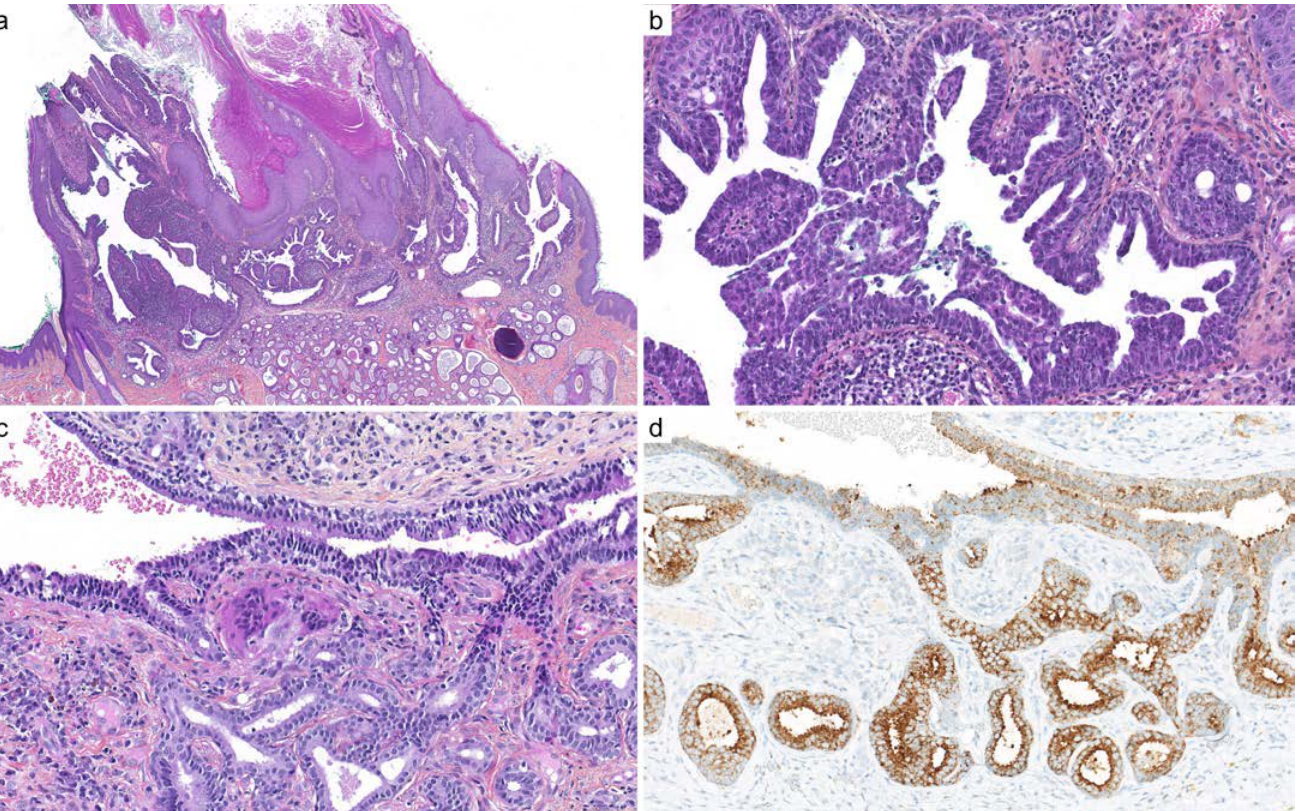
Figure 8. Syringocystadenoma papilliferum and tubular adenoma: ( a ) hybrid lesion with superficial syringocystadenoma papilliferum and dermal tubular adenoma arising on a nevus sebaceous, with verrucous change (×10) ; ( b ) syringocystadenoma papilliferum shows papillary projections, epithelial and myoepithelial cells, and numerous plasma cells in the adjacent dermis (×100); ( c ) tubular adenoma exhibits numerous ducts, tubes, and cysts with apocrine decapitation (×200); ( d ) BRAF p.V600E (clone VE1) immunohistochemistry intensely and diffusely stains the cytoplasm of neoplastic cells (×200).